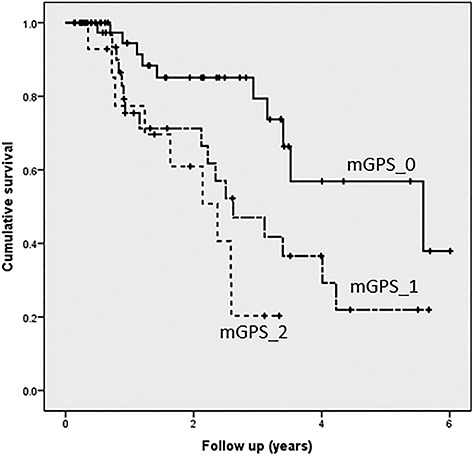
The 2-year OS rate for all patients, mGPS_0, mGPS_1, and mGPS_2 were 75.7%, 85.1%, 71.3%, and 60.9%, respectively.